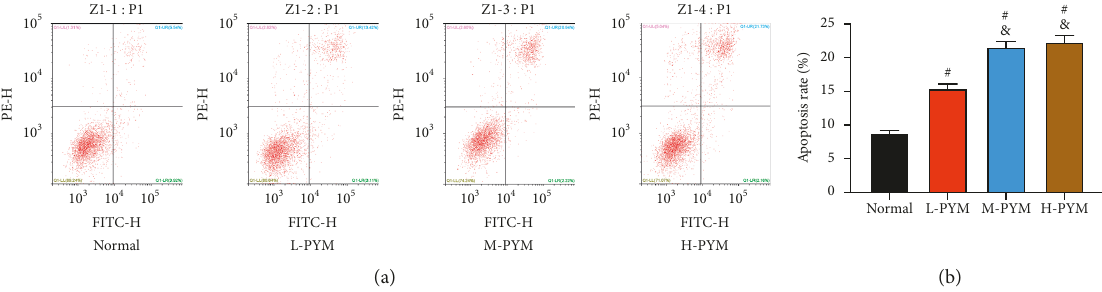
0 . 05. Compared with the L-PTM group, & P <